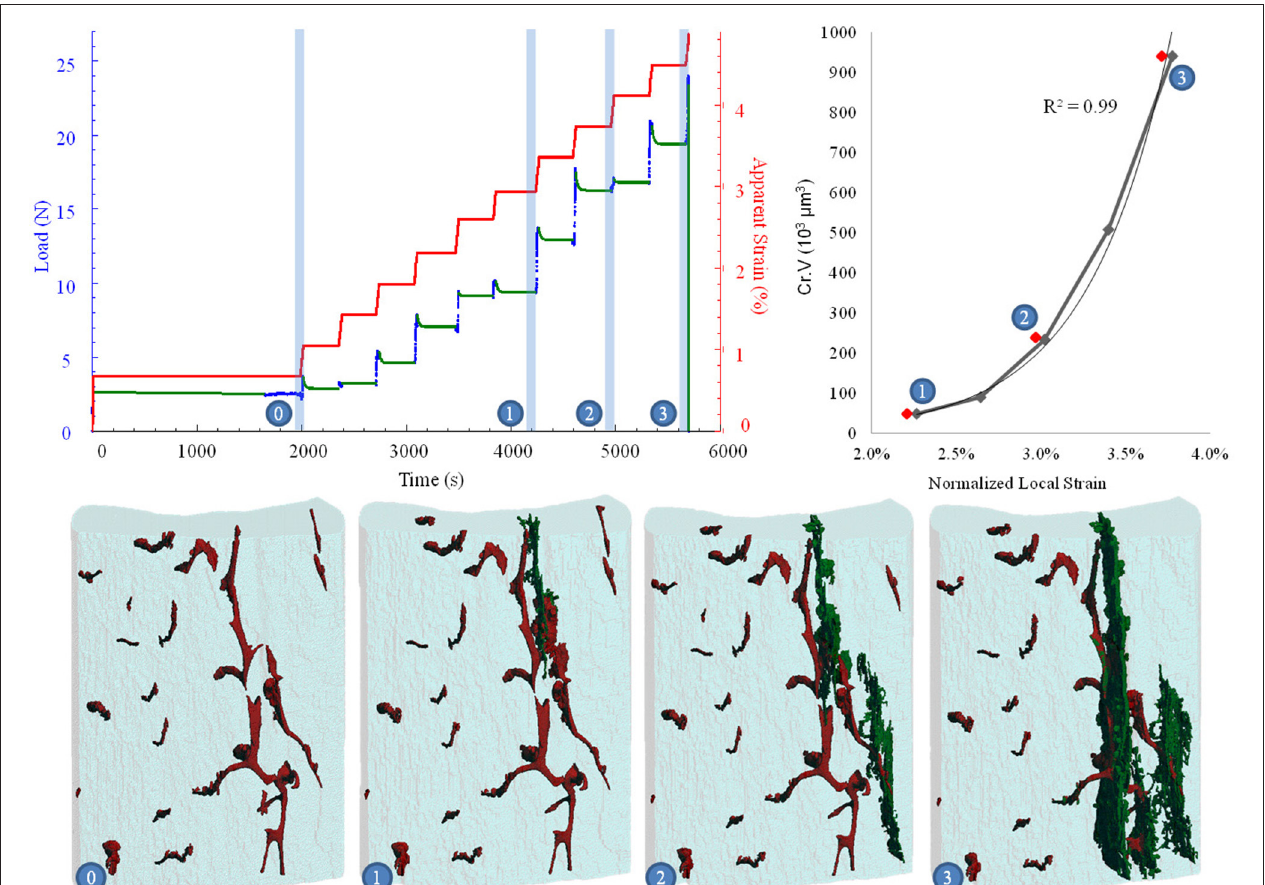
FIGURE 4 | Biomechanical imaging combining bone mechanics (top left) and image-guided failure assessment ( bottom and top right ). (Top left) Blue and red plots show applied loads and corresponding apparent strains in the sample as a function of time. Time slots of stress relaxation and failure are shown in green. (Top right) Microcrack growth with the increase in applied strains, showing the equation of the fitted exponential function and the corresponding coefficient of determination. (Bottom) Visualized bone microstructure, where canal network is shown in red, microcracks in green, and cortical bone outline in light blue. (0–3) denote matching time points in all